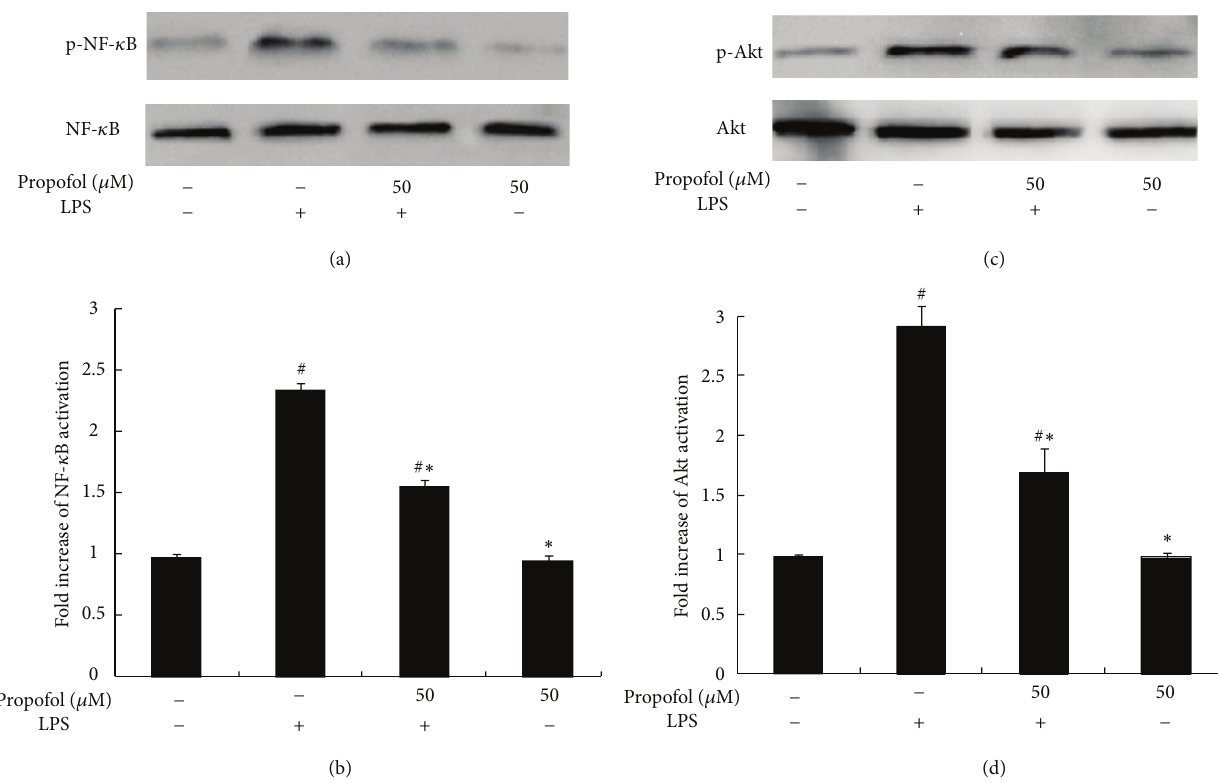
Figure 3: Effect of propofol pretreatment on LPS-induced phosphorylation of nuclear NF- 𝜅 B and Akt. (a), (c) The cells were pretreated with dimethyl sulfoxide (DMSO) or propofol for 40 min and then stimulated with LPS for 1h. Nuclear NF- 𝜅 B and Akt activation, indicated by phosphorylation, was analyzed by Western blotting on whole cell lysates. (b), (d) The levels of phosphorylated NF- 𝜅 B (p-NF- 𝜅 B) and phosphorylated Akt (p-Akt) were quantified by measuring band intensities and represented as fold change over total NF- 𝜅 B and Akt. Each value represents the means ± SD for 𝑛 = 4 . # and ∗ indicate statistically significant differences ( 𝑃 < 0.05 ) between propofol and LPS treated and LPS only treated groups,